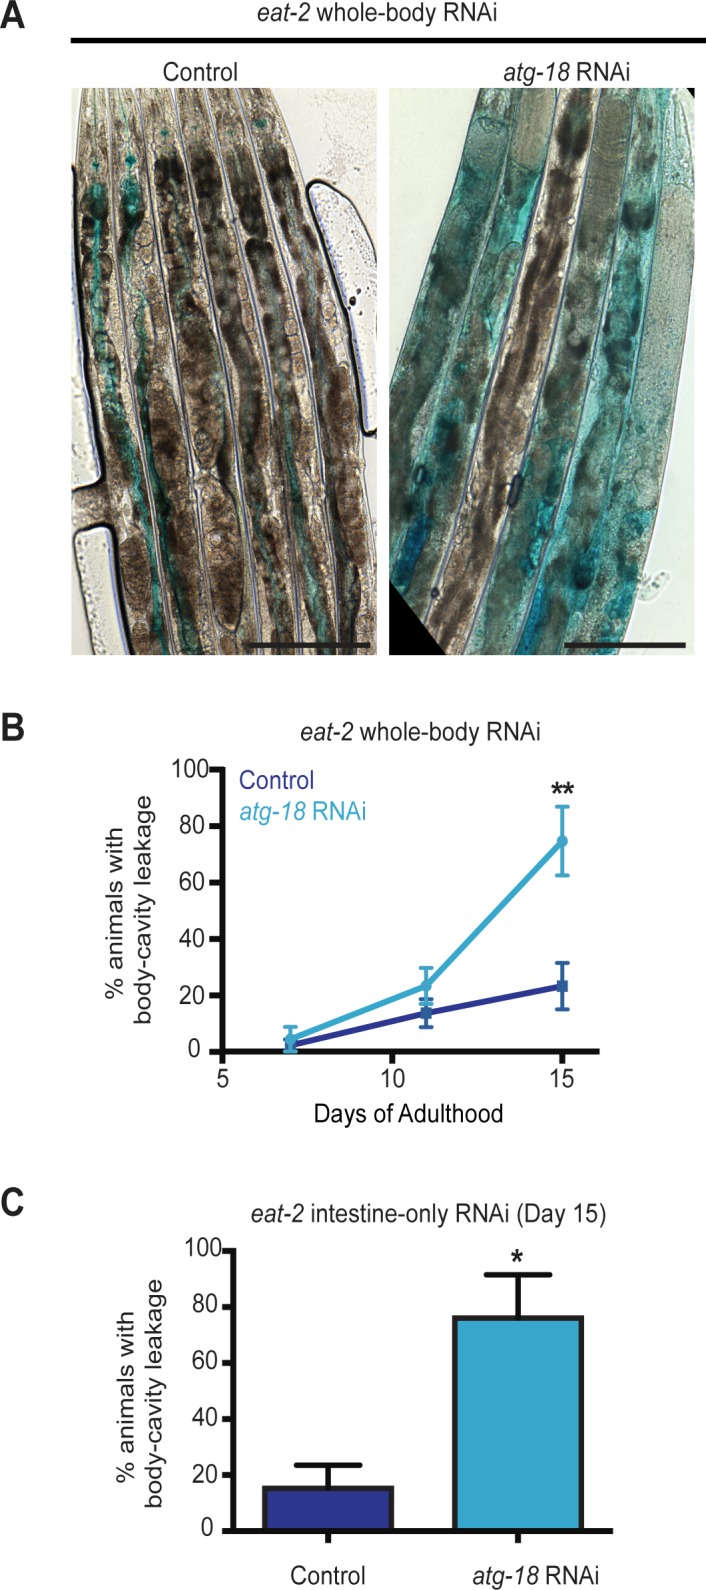
Autophagy-gene knockdown reduces the intestinal integrity of dietary-restricted eat-2 mutants.(A) DIC images of eat-2(ad1116) animals fed from Day 1 of adulthood with bacteria containing empty vector (control) or expressing atg-18/Wipi-targeting dsRNA, and then soaked in blue food dye for 3 h on Day 15 of adulthood. Scale bars, 200 μm. (B) Quantification of body-cavity leakage in eat-2(ad1116) animals fed from Day 1 of adulthood with bacteria containing empty vector (control) or expressing atg-18/Wipi-targeting dsRNA. Data are the mean ± SEM of three biological repeats, each with 8–10 animals per time point. **P = 0.005, Student’s t-test. (C) Quantification of body-cavity leakage in 15-day-old eat-2(ad1116); rde-1(ne219); nhx-2p::rde-1 transgenic animals fed from Day 1 of adulthood with bacteria containing empty vector (control) or expressing atg-18/Wipi-targeting dsRNA. Data are the mean ± SEM of three biological repeats, each with 8–10 animals. *P = 0.025, Student’s t-test.